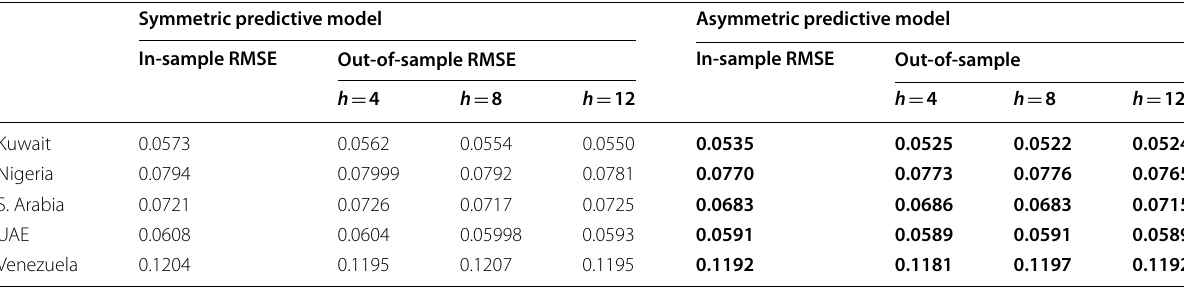
The bolded values are the smaller RMSE values, which give better forecasting accuracy of the predictive